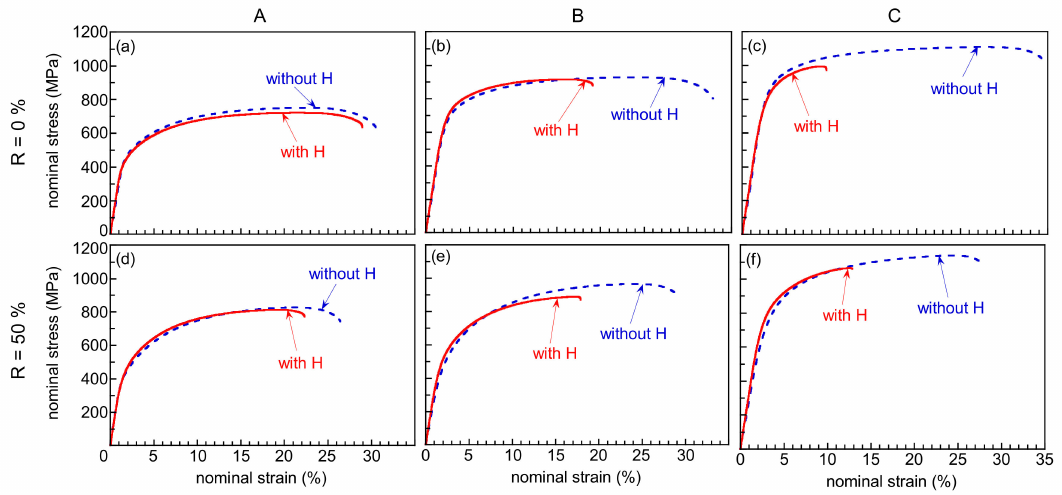
Figure 3. Nominal stress–strain curves of ( a , b , c ) conventional and ( d , e , f ) hot-forged steels ( a , d ) A, ( b , e ) B, and ( c , f ) C with and without hydrogen. R represents reduction ratio.